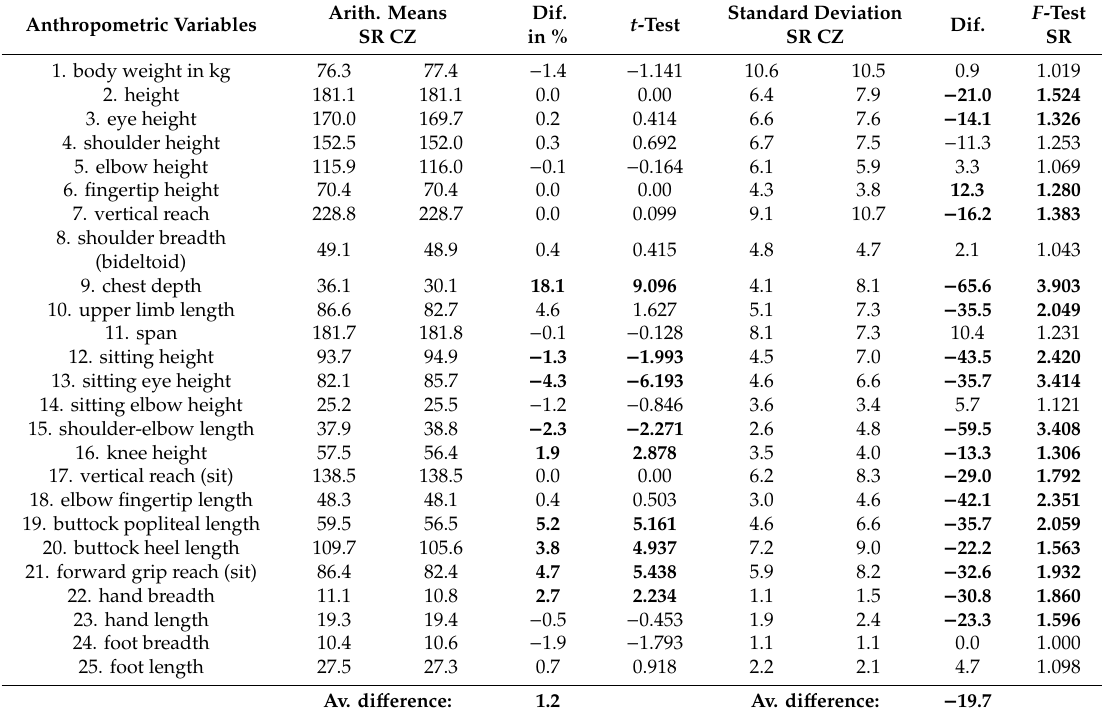
Table 3. Basic characteristics of anthropometric variables and their variation in the Slovak and Czech male population in the year 2004.